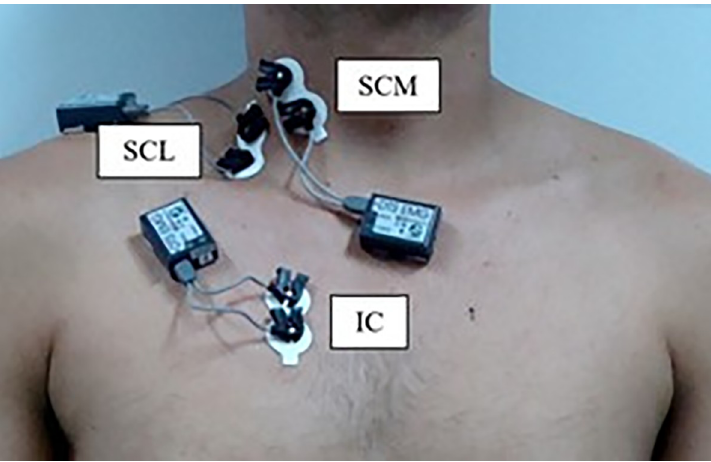
Fig 1. Representation of the electromyography electrodes positioning on SCL, SCM and IC muscles.